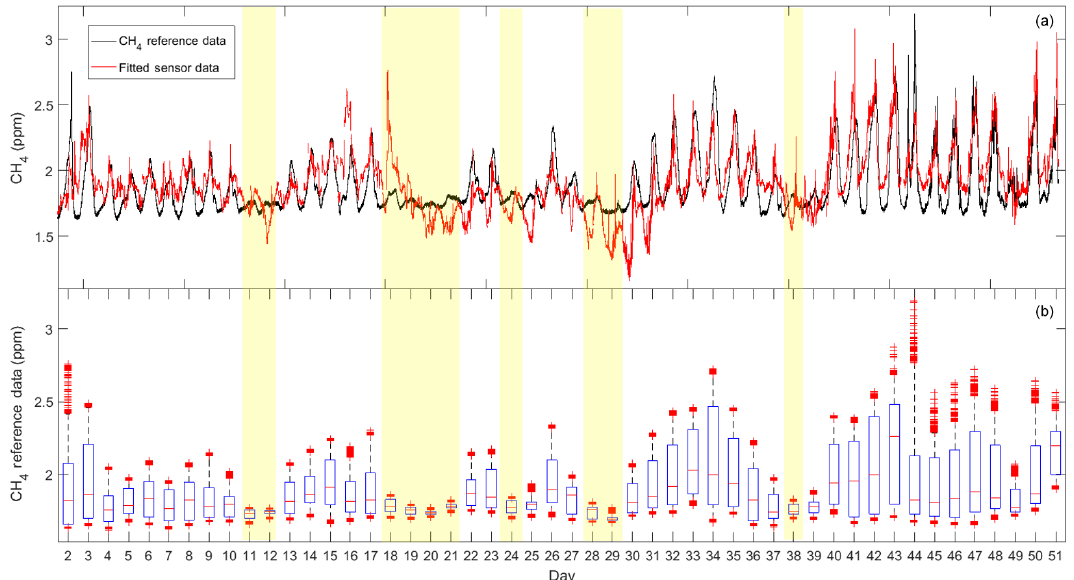
Figure B1. Panel (a) includes time series of methane reference data and fitted sensor data. Panel (b) includes the methane data for the Validation 2 dataset binned by days. The yellow segments highlight periods when underestimations below atmospheric background were removed, which coincide with days where the dynamic range is less than the expected uncertainty (RMSE is